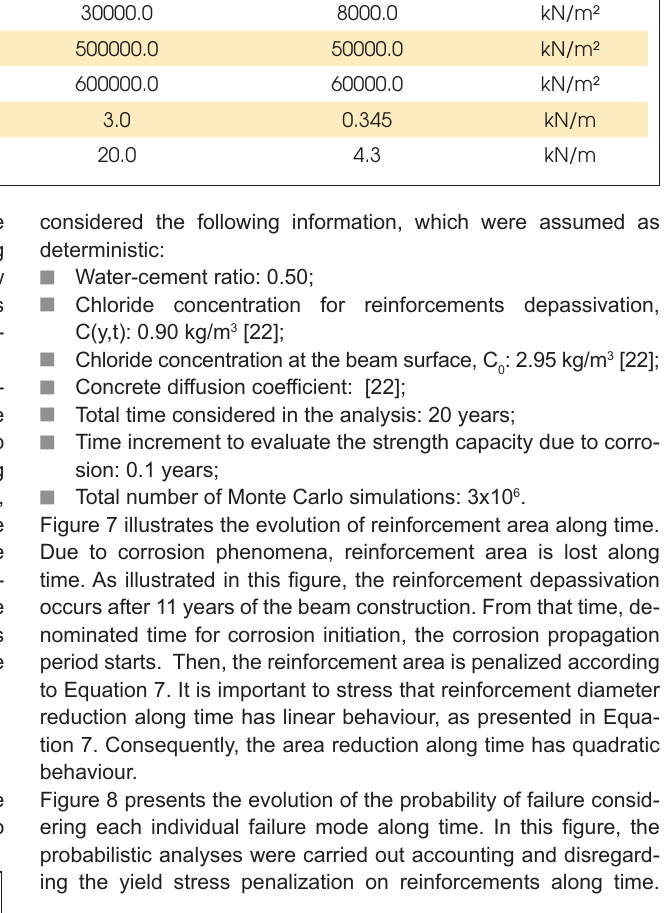
Figure 8 – Evolution on the probability of failure considering individual failure